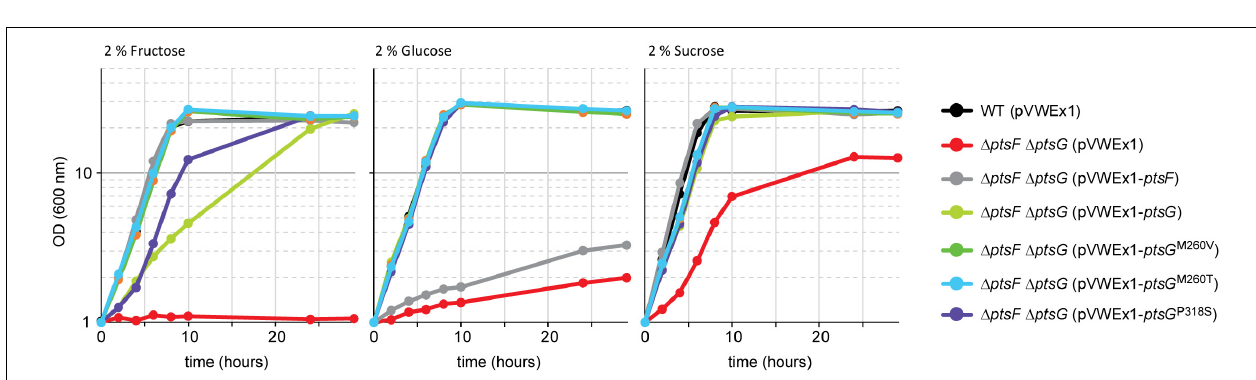
FIGURE 5 | Growth complementation of the (cid:49) ptsF (cid:49) ptsG strain by overexpressing PtsG variants. Data represent one of two individual cultivations that differed < 5%.